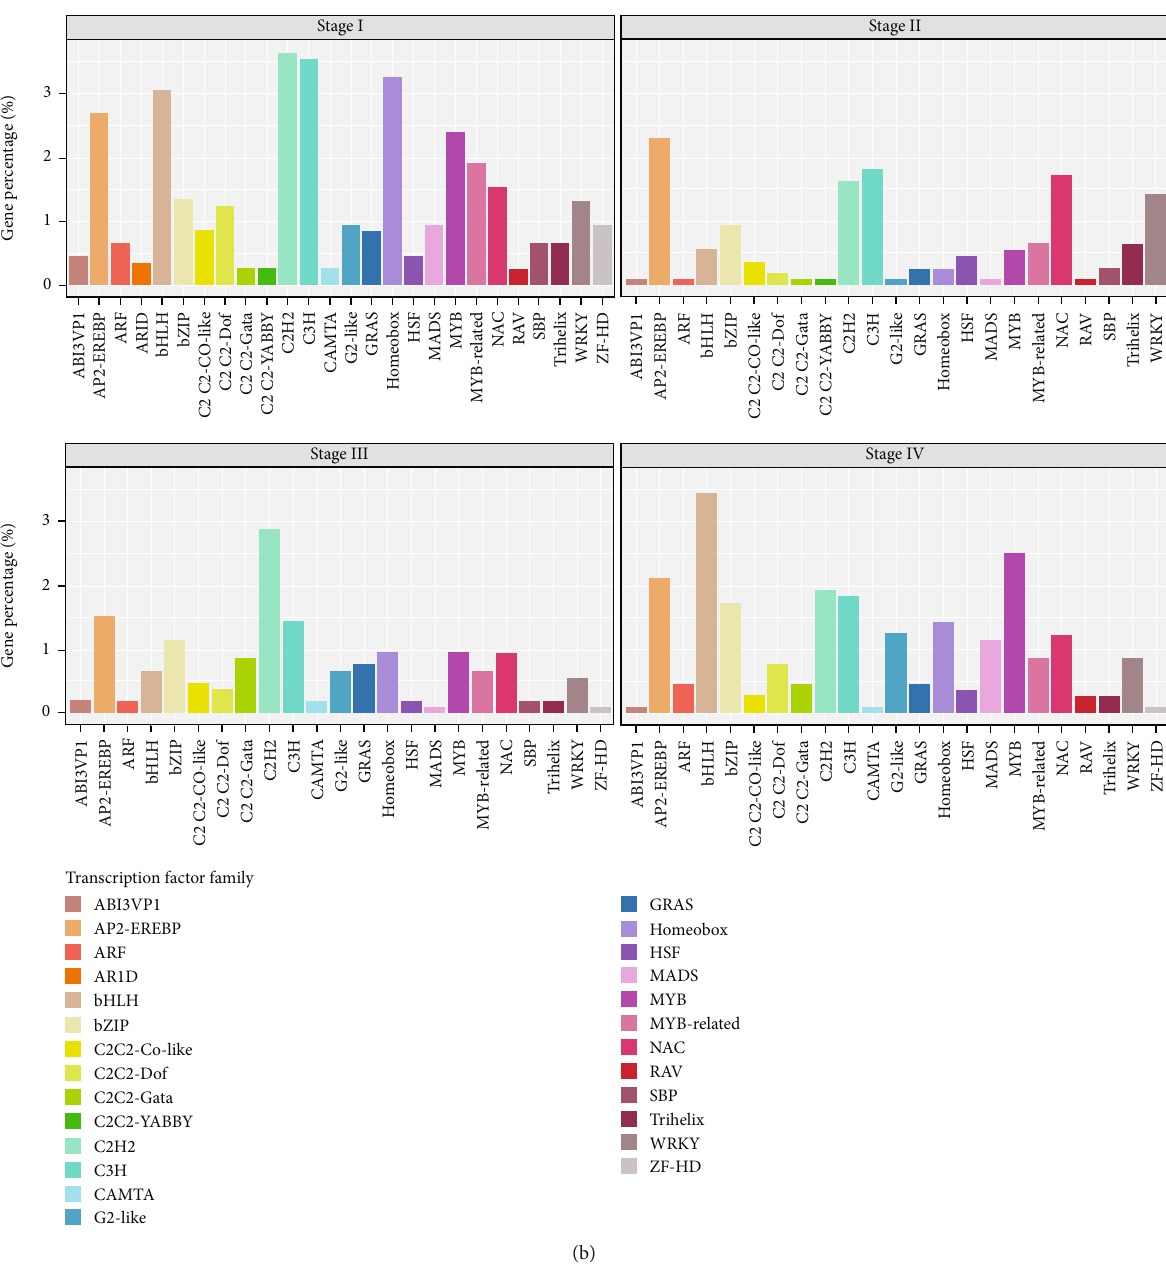
Figure 11: Distribution of TFs in SE. (a) Overall distribution of TFs. The percentage is calculated as the ratio of TFs belonging to each family with respect to the total number of TFs in the network. (b) Distribution of SE-related TFs across di ff erent somatic embryo developmental stages. The percentage is calculated for each stage as the ratio of TFs present in each family with respect to the total number of TFs in the